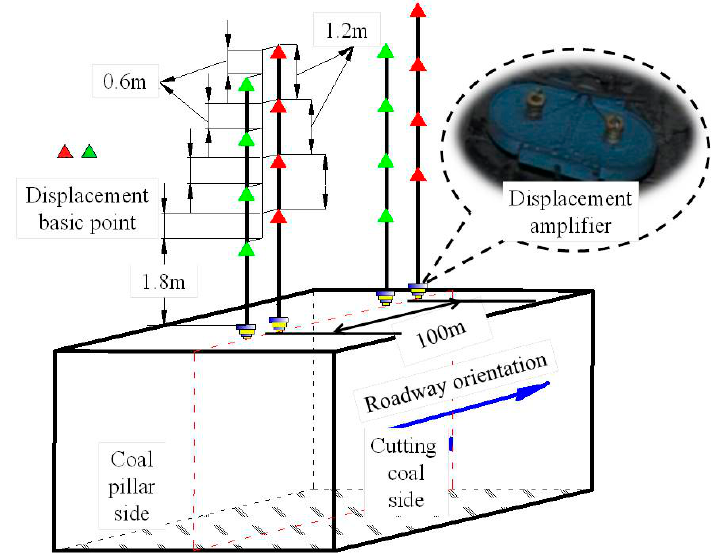
Figure 9. Displacement base point arrangement scheme of high-density deep displacement monitor of roadway roof.